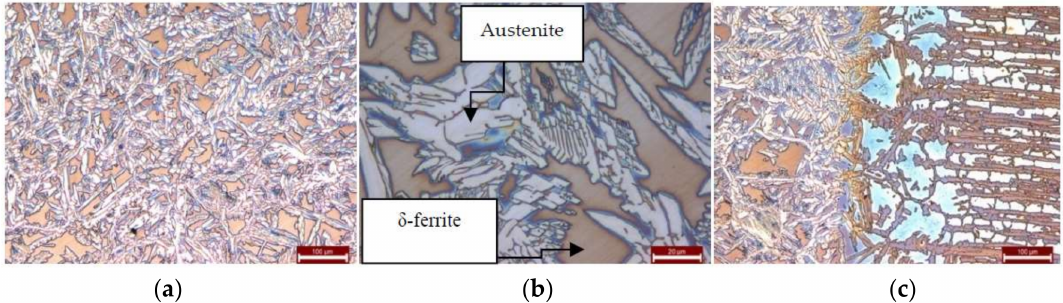
Figure 4. Micrographs of specimen A joined by pure argon shielding gas ( a ) weld metal 100 × ( b ) weld metal 500 × ( c ) heat effected zone (HAZ) 100 × .